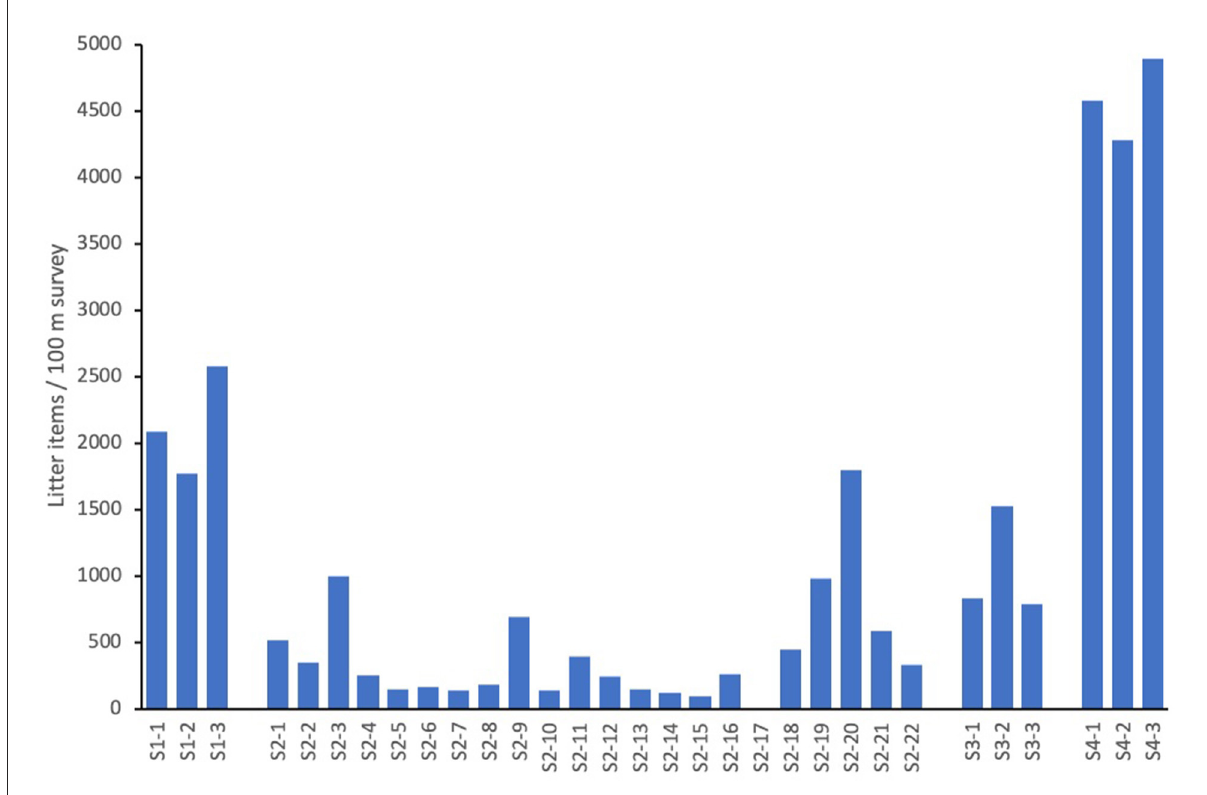
FIGURE2 Abundance of litter items at each site and for each sampling occasion. Data for S4 were collected over a 50m transect and here were standardized to 100m